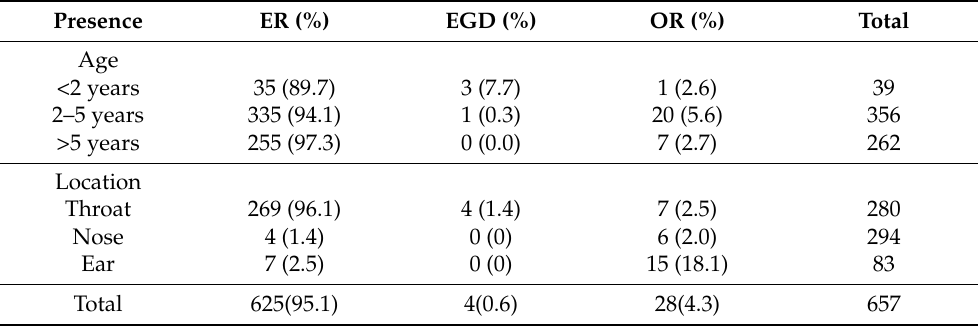
Table 5. Methods of foreign body removal in the age groups and